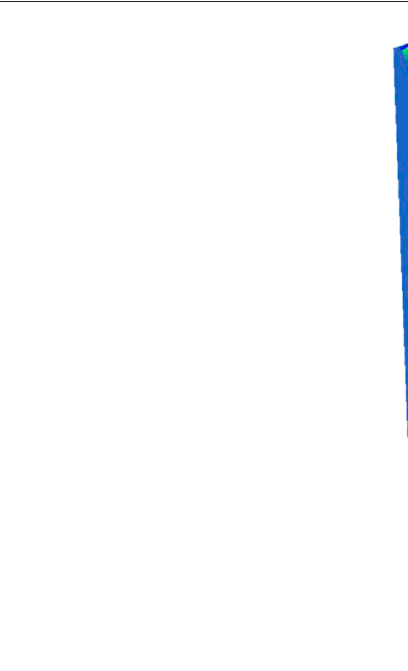
FIGURE 12 | Movement trajectory of the rock block.